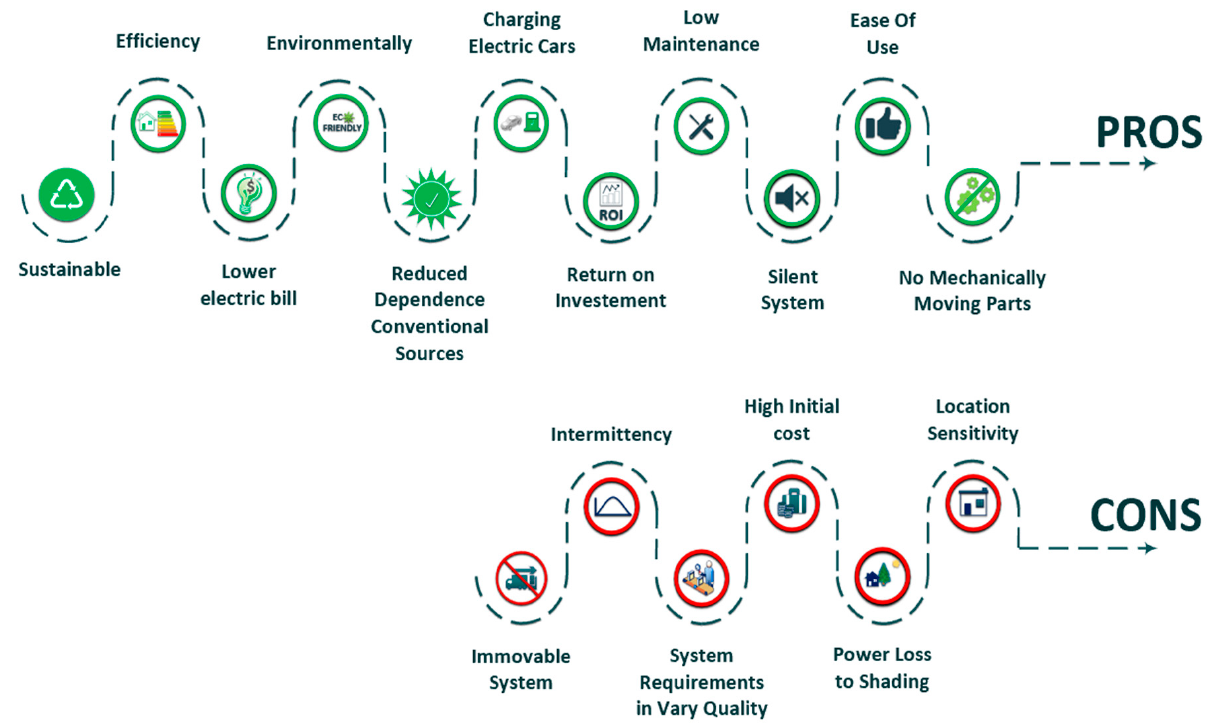
Figure 3. Advantage and problems of residential PV systems .